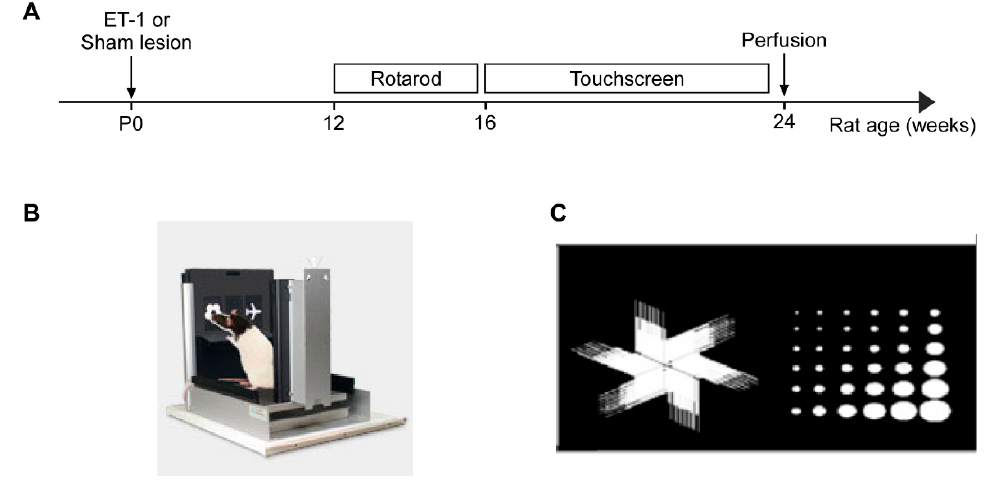
Figure 5. ( A ) Timeline showing time of ET-1 induced neonatal ischemia, behavioural testing and brain tissue collection. ( B ) Representative image of the Bussey-Saksida rat touch screen chamber ( C ) Visual stimuli used in the pairwise discrimination task.